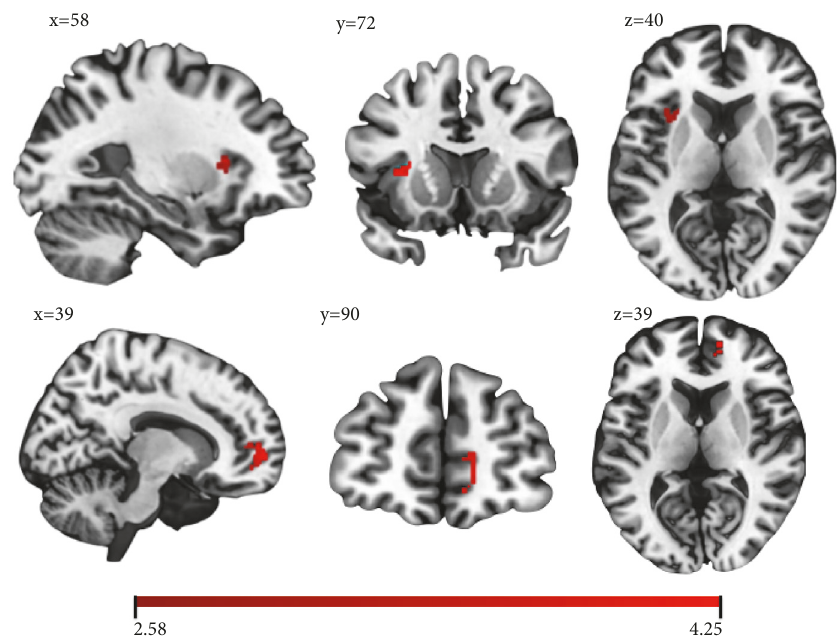
Figure 2: Greater activation in the ASD group relative to the TDC group in the left insula (top row) and in the right frontal pole (bottom row) during the threshold unsigned prediction error (UPE) contrast. Color bar represents the range of